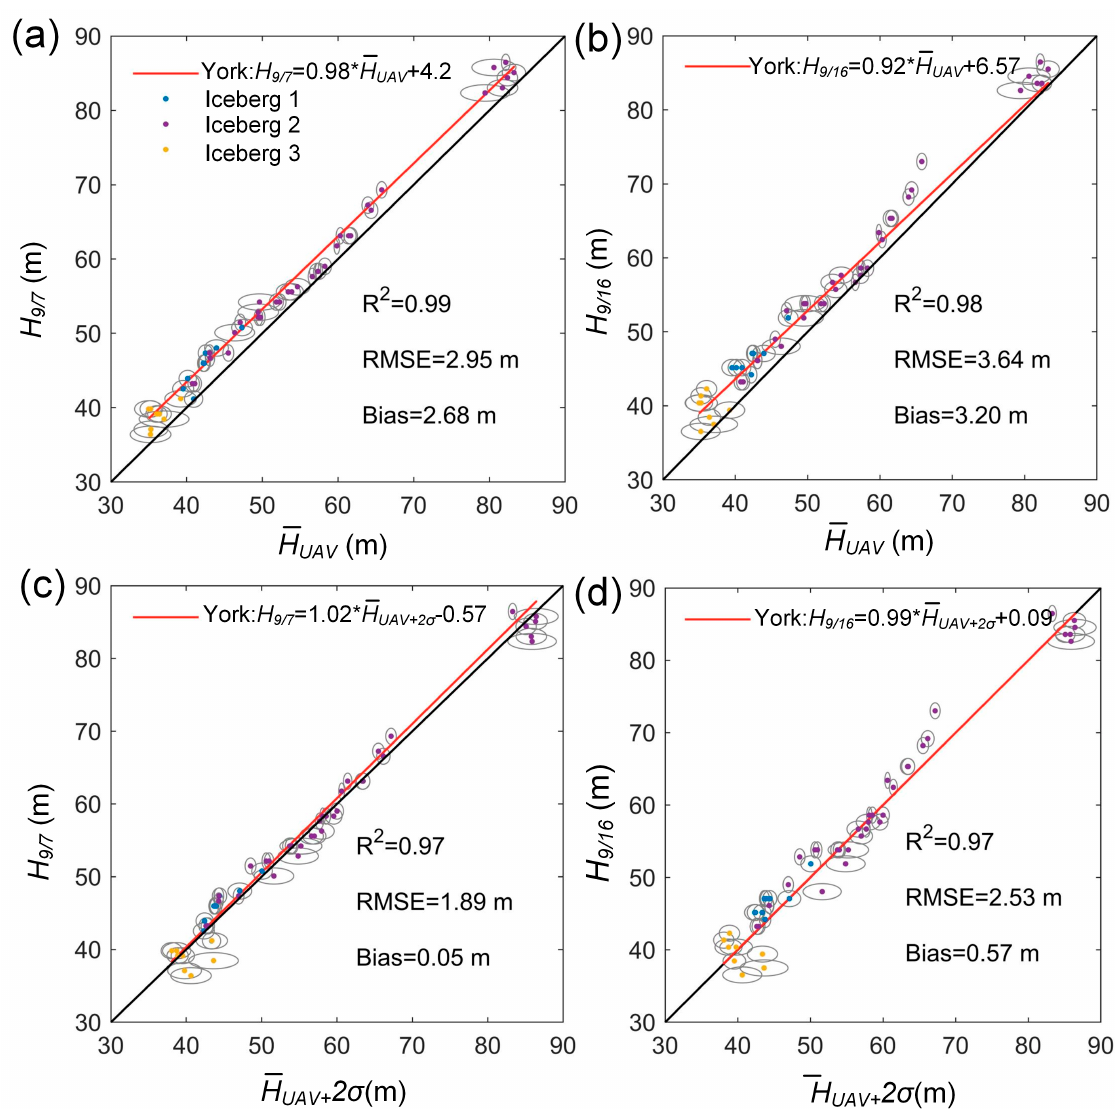
Figure 7. The comparison between the shadow freeboard and UAV freeboard, the ( a ) H 9/7 and H UAV 12/13 , ( b ) H 9/16 and H UAV 12/13 , the ( c ) H 9/7 and H UAV 12/13 + 2 σ UAV 12/13 , and the ( d ) H 9/16 and H UAV 12/13 + 2 σ UAV 12/13 . The red lines show the York’s linear fit between the data. The fit considered the estimated precision of the shadow freeboard H 9/7 and H 9/16 , the precision of the UAV freeboard, and the standard deviation of the H UAV 12/13 . The black line is the 1:1 line.